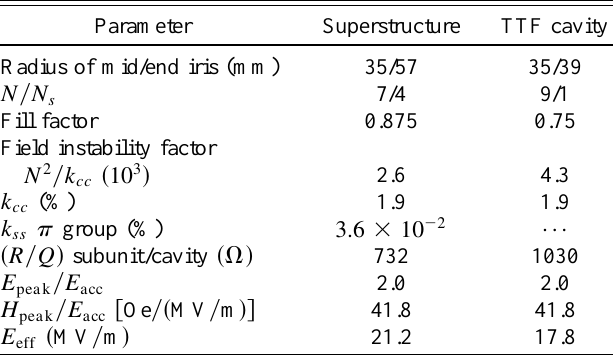
TABLE I. Parameters of the superstructure and the TTF cavity. Parameter Superstructure TTF cavity Radius of mid/end iris (mm) 35/57 35/39 (cid:78) (cid:121) (cid:78) (cid:115) Field instability factor